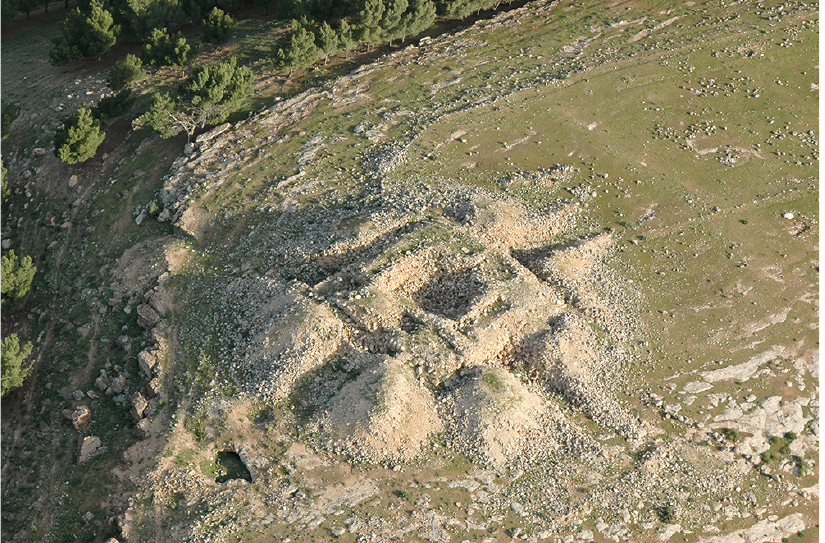
Figure 3: Oblique aerial view of the Iron Age watchtower at Rujm al-Mukhayyat (Kennedy & Bewley, 2007; APAAME_20070417_DLK-0137).